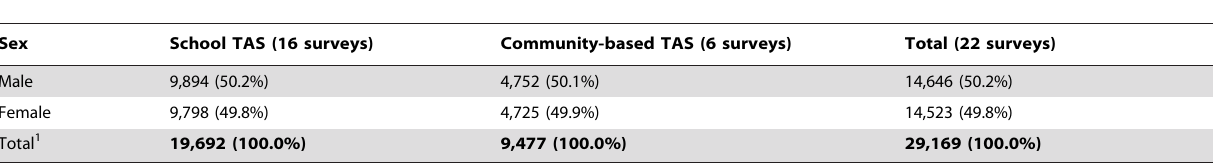
Table 5. TAS sample size by sex for school and community-based surveys.